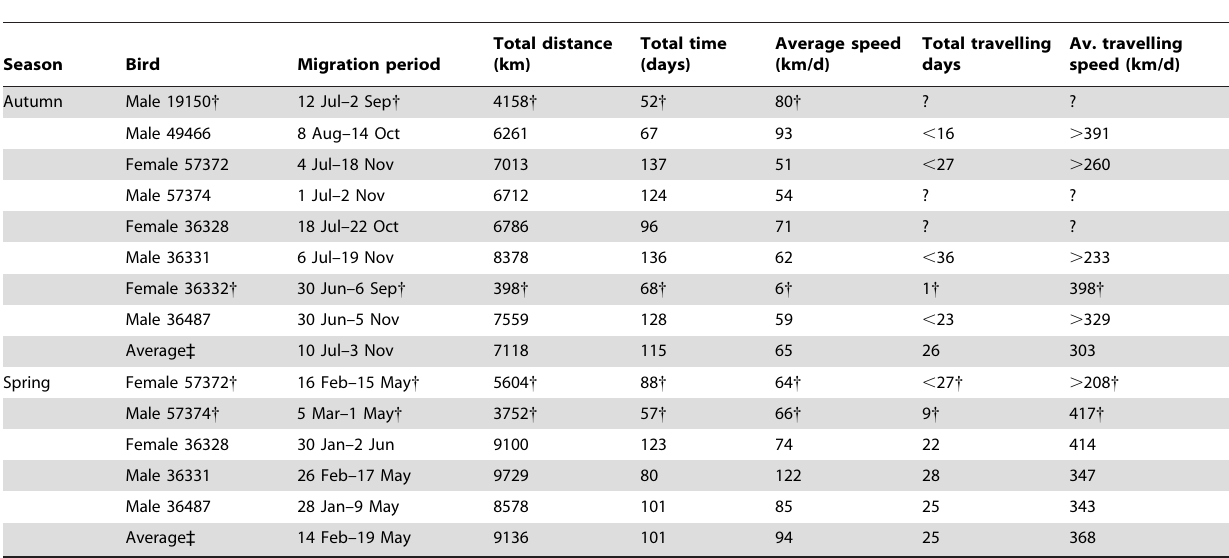
Table 2. Summary table of the autumn and spring migration of eight adult common cuckoos tracked from southern Scandinavia.